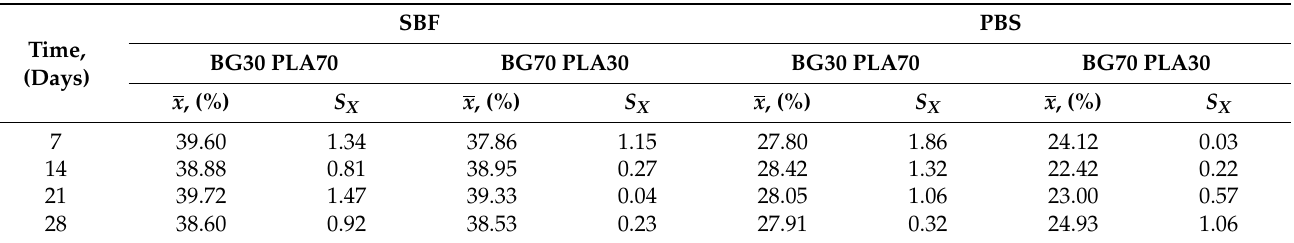
Table 4. Average weight loss ( X ) and standard deviation ( S X ) for the scaffolds immersed in SBF and PBS over time periods of 7, 14, 21, and 28